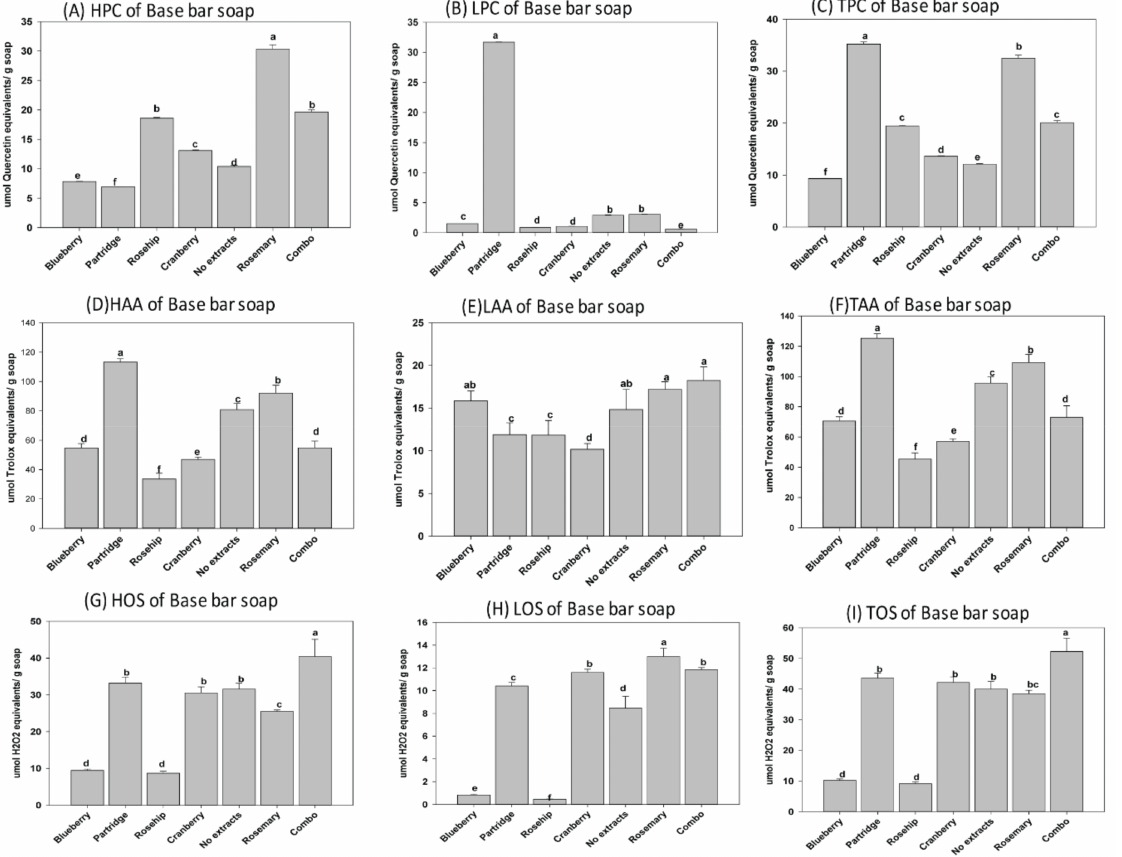
Figure 2. Hydrophilic, lipophilic and total ( A – C ) phenolics, ( D – F ) antioxidants, and ( G – I ) oxidant status in base bar (BB) natural soaps following manufacturing by cold saponification. Bars represent means ± standard errors. Error bars with di ff erent letters (a–f) are significantly di ff erent among treatments at LSD = 0.05, n = 4 per experimental replicate. HPC = hydrophilic phenolic content, LPC = lipophilic phenolic content, TPC = total phenolic content, HOS = hydrophilic oxidant status, LOS = lipophilic oxidant status, TOS = total oxidant status, HAA = hydrophilic antioxidant activity, LAA = lipophilic antioxidant activity, and TAA = total antioxidant activity. Combo = 25% of each of the blueberry, cranberry, and partridge berry and rosehip